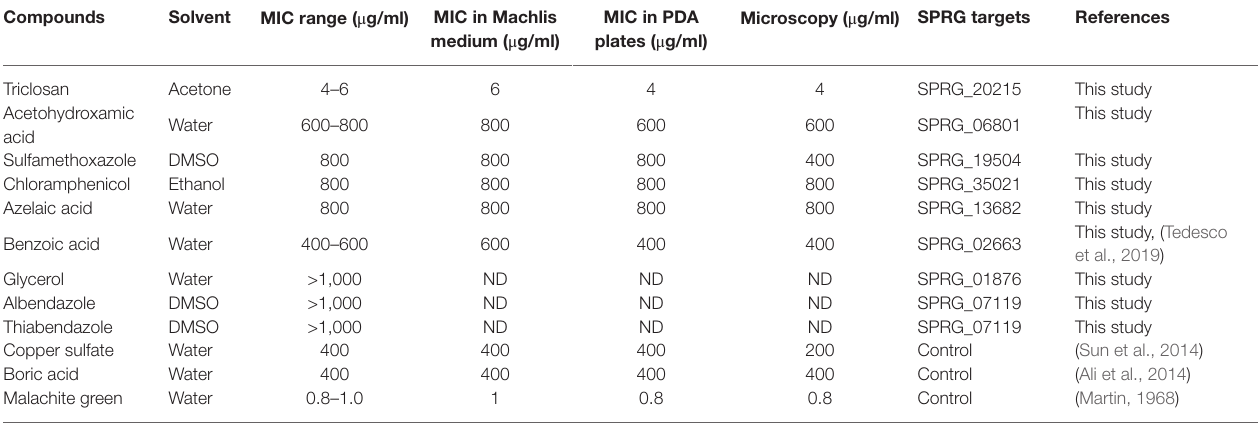
TABLE 2 | In-vitro screening of the selected compounds on the growth of S. parasitica hyphal cells. Compounds